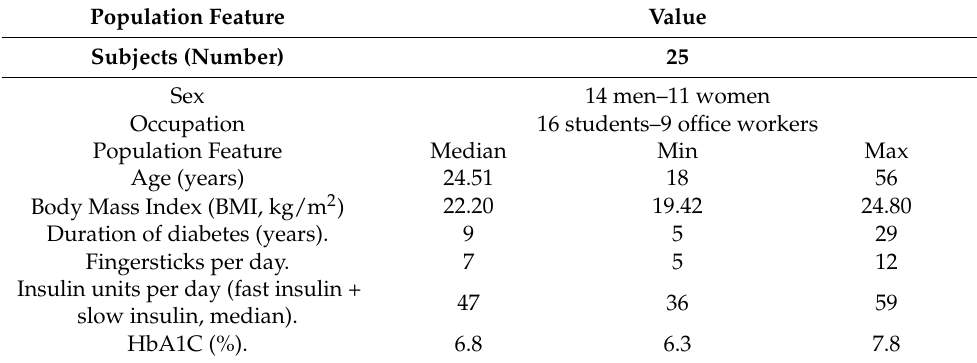
Table 1. Data regarding the patients considered in the